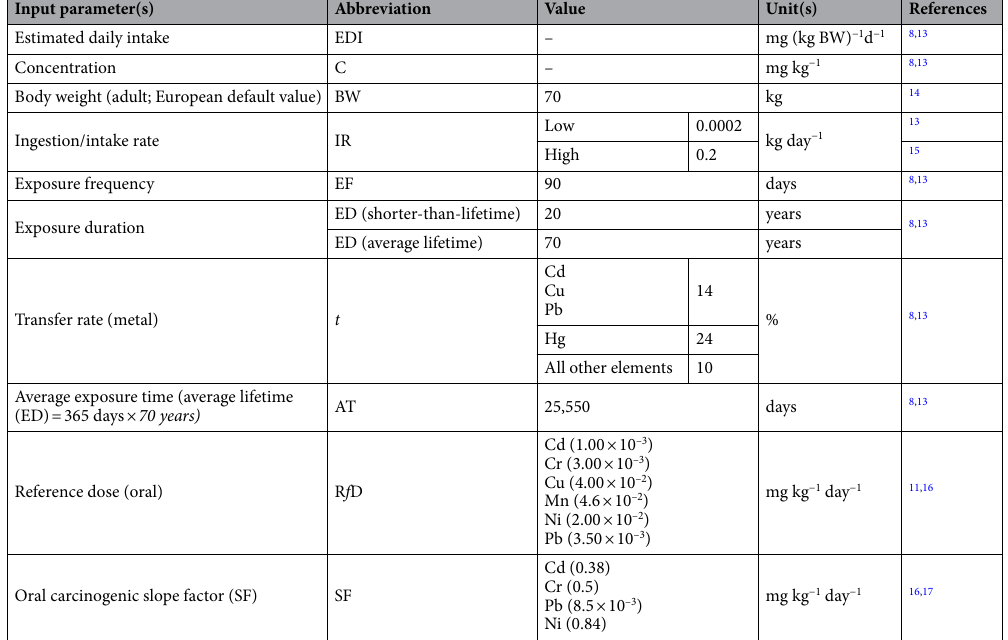
Table 4. List of input data for the evaluation of exposure and risk (Eqs. (1) to